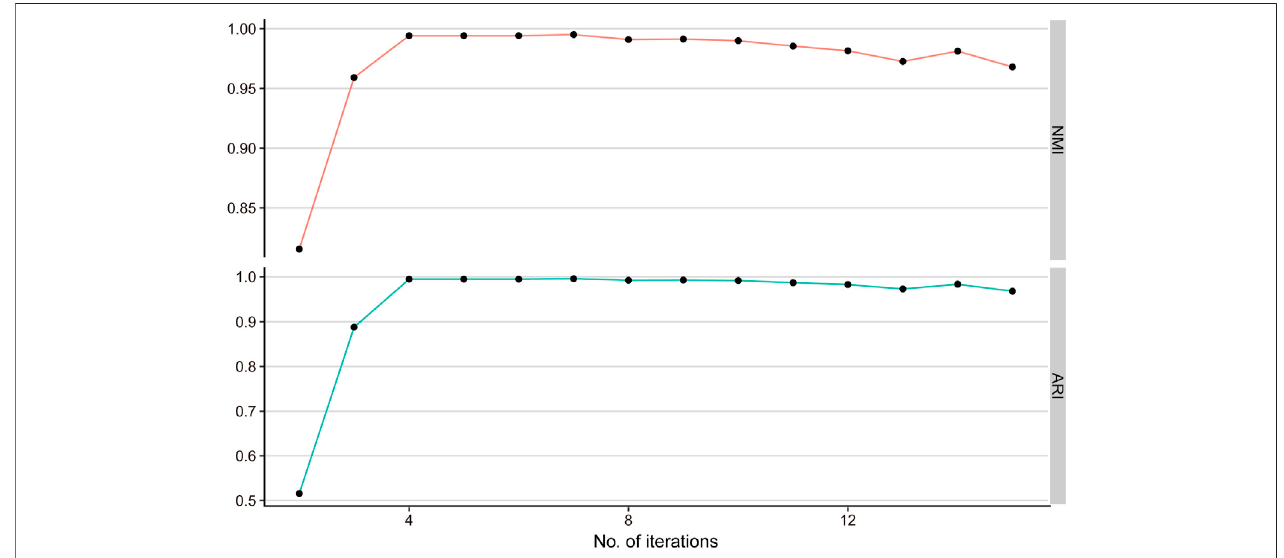
FIGURE 2 | Simulation study for selecting the best iteration step. NMI and ARI values for varying iteration steps from 2 to 15 determine the optimal iteration step t (cid:1) 4.